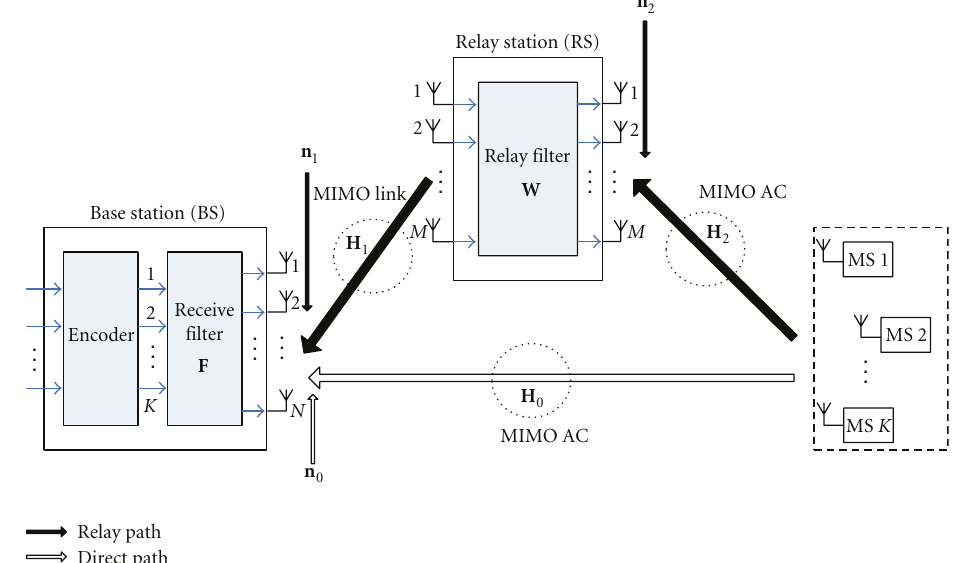
Figure 2: Multiuser cooperative MIMO relay system model in